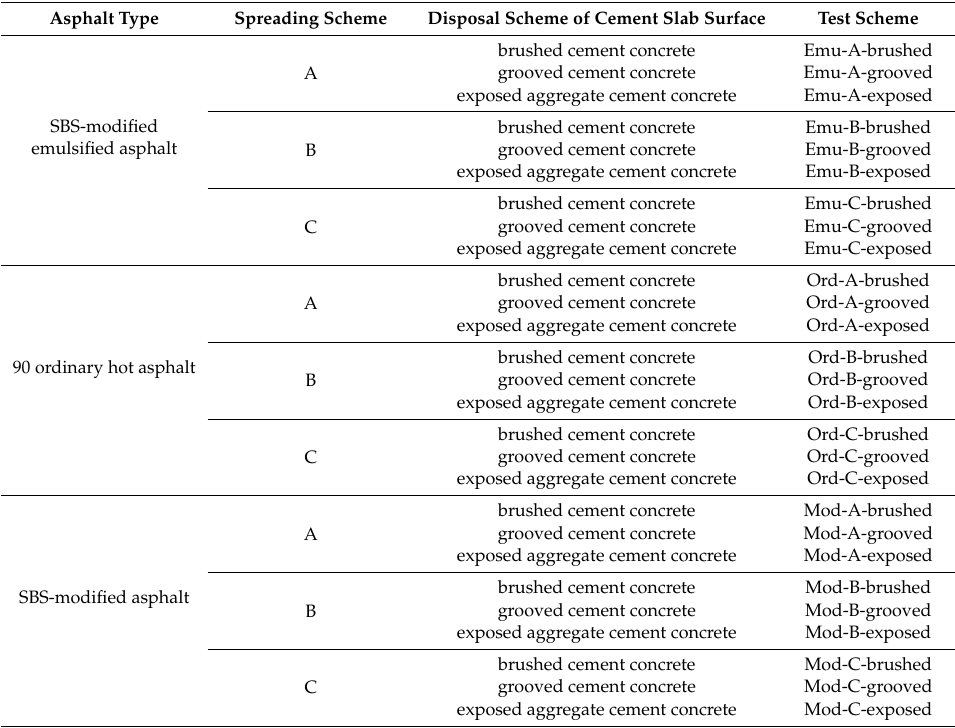
Table 1. Composition of 27 test schemes.